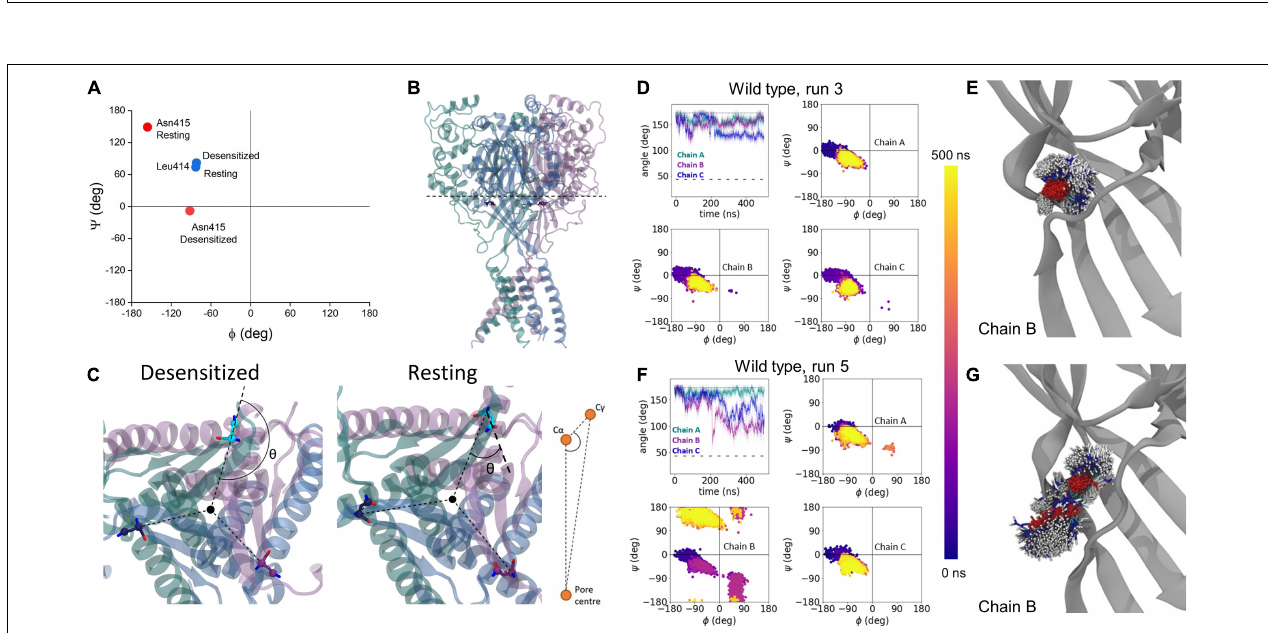
FIGURE 4 | Analysis of transitions to resting state using molecular dynamics simulations. (A) Phi/psi plots of Leu414 (blue) and Asn415 (red) in desensitized and resting states. (B) Slice-through of the desensitized state structure to show the plane of angle defined in panel (C) . (C) Illustration of change in side chain angle, with respect to C γ and channel center in desensitized and resting states. (D) Example of wild type run where no substantial changes were seen in the side chain angle (upper left), or phi/psi plots in each chain (upper right, lower panels). The dotted line illustrates the side chain angle of N415 in the desensitized state structure while the dashed line illustrates the side chain angle in the resting state structure. (E) Overlay of 1000 Asn415 positions at regular intervals over the 500 ns simulation. (F,G) Same as panels (D,E) but for wild type run where motion toward a resting-like conformation was observed in chain B.